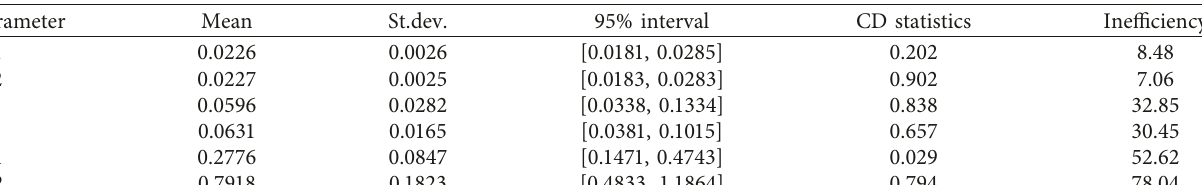
Figure 4: Liquidity characteristics of China’s real estate market in the high and low volatility states. Table 4: Estimation parameters of the TVP-SV-VAR